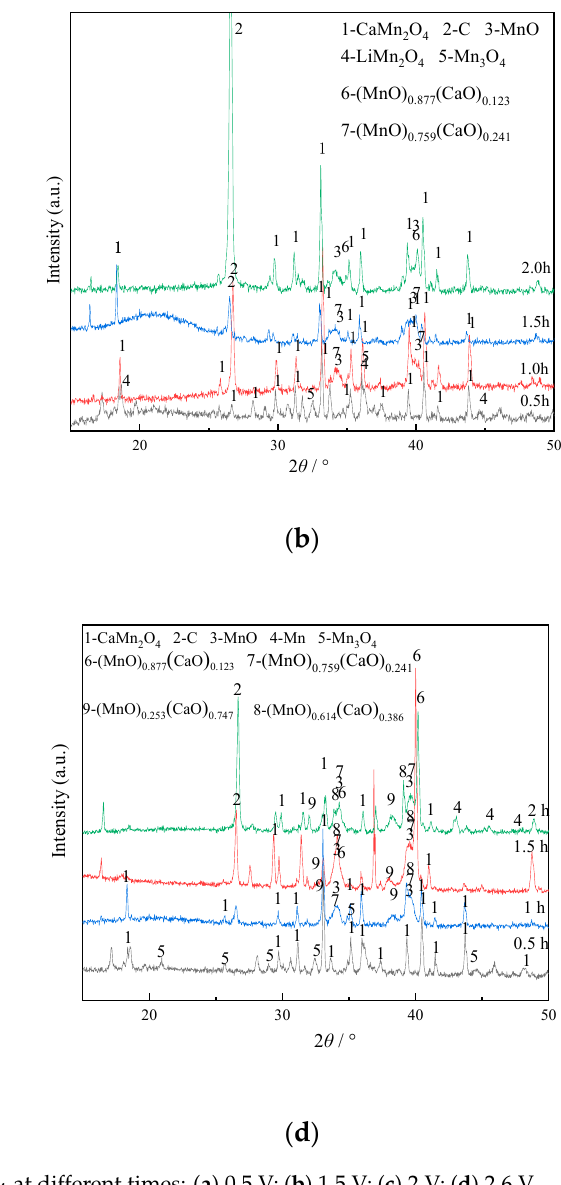
Figure 10. XRD analysis of electro deoxidation products of LiMn 2 O 4 at different times: ( a ) 0.5 V; ( b ) 1.5 V; ( c ) 2 V; ( d ) 2.6 V. The electrolysis products of LiMn 2 O 4 at different voltages in a short period of time have consistent changes. LiMn 2 O 4 (III, IV) has undergone a gradual reduction process from trivalent manganese, bivalent manganese to elemental manganese. At 0.5 V electrical deoxidation for 0.5 h, the products are mainly LiMn 2 O 4 with a small amount of CaMn 2 O 4 and Mn 3 O 4 . When the time increases to 1~1.5 h, LiMn 2 O 4 disappears, CaMn 2 O 4 increases, and (MnO) 0.614 (CaO) 0.386 is produced. As the time is increased to 2 h, (MnO) 0.614 (CaO) 0.386 in the product decreased, some characteristic peaks of (MnO) 0.759 (CaO) 0.241 appeared at the same time, and the peak intensity of products containing Mn (II) increased and CaMn 2 O 4 decreases. When the electro-deoxygenation is 0.5 h, the composition of the 1.5 V product is the same as that of the 0.5 V product, but 1.5 V produces are more CaMn 2 O 4 . When deoxidation time was increased to 1 h, the characteristic peaks of LiMn 2 O 4 and Mn 3 O 4 all disappeared, and the product was still dominated by CaMn 2 O 4 . At the same time, characteristic peaks of MnO and (MnO) 0.759 (CaO) 0.141 appeared. Compared with 0.5 V, the product at the same time of 1.5 V contains more Mn (II), and with the extension of electrolysis time, the amount of MnO gradually increases, and the characteristic peak intensity of CaMn 2 O 4 decreases. When the time reaches 2 h, the characteristic peak of (MnO) 0.877 (CaO) 0.123 which contains more MnO appears in the product. The electrolysis